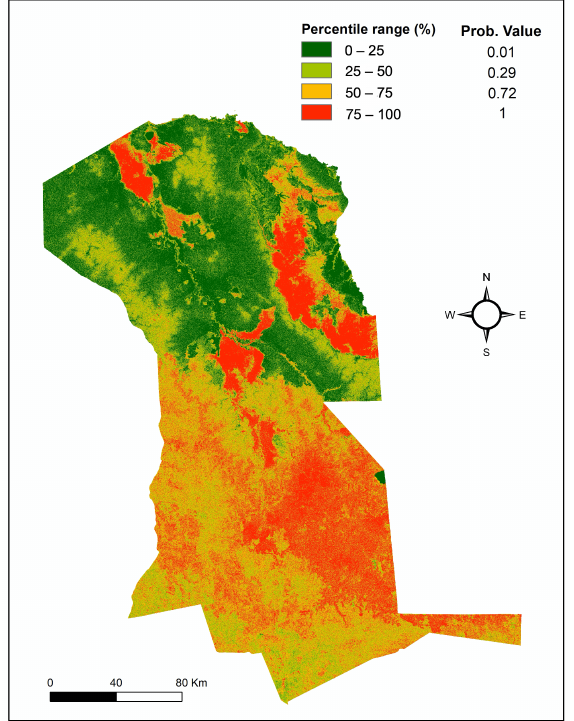
Figure 12. Wildfire susceptibility map of San Ignacio de Velasco